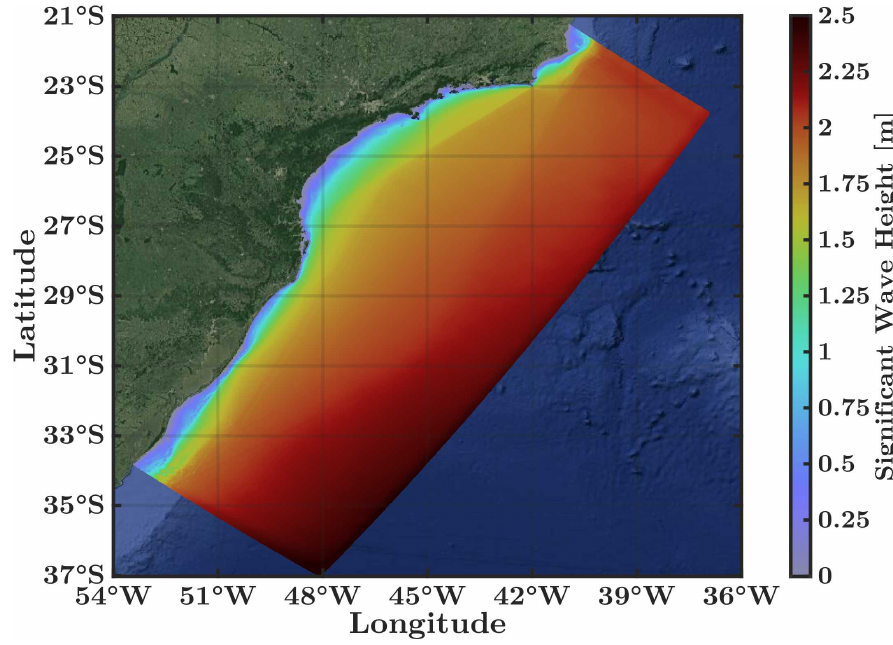
Figure 5. Mean value of significant wave height H s (m) over 18 years.